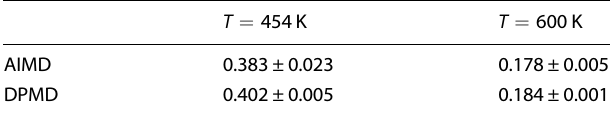
Fig. 5 we display the distributions of the logarithm of these estimates from trajectory segments of different length (100-, 200-, and 400-ps) and report the p-values of the Shapiro-Wilk (SW) normality test 80 for each distribution. We observe that: i) at T ≈ 450 K the WS test is failed for segments shorter than 400-ps, indicating the subsistence of slow stress fl uctuations that